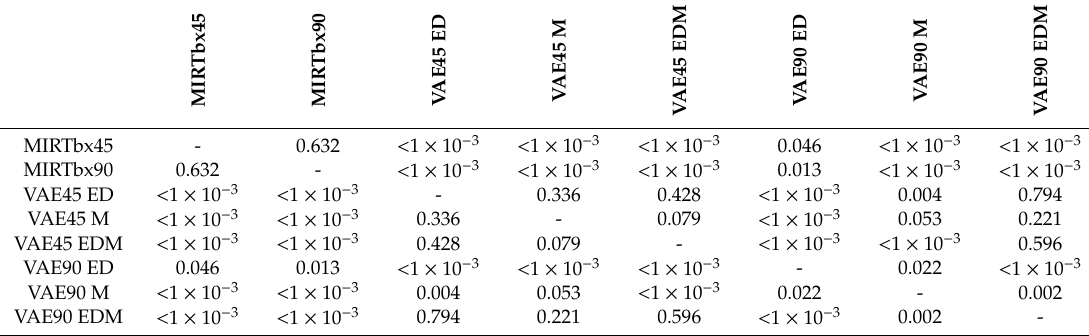
Table 4. Matrix of p -values obtained for Dunn’s post hoc test associated with the SVM